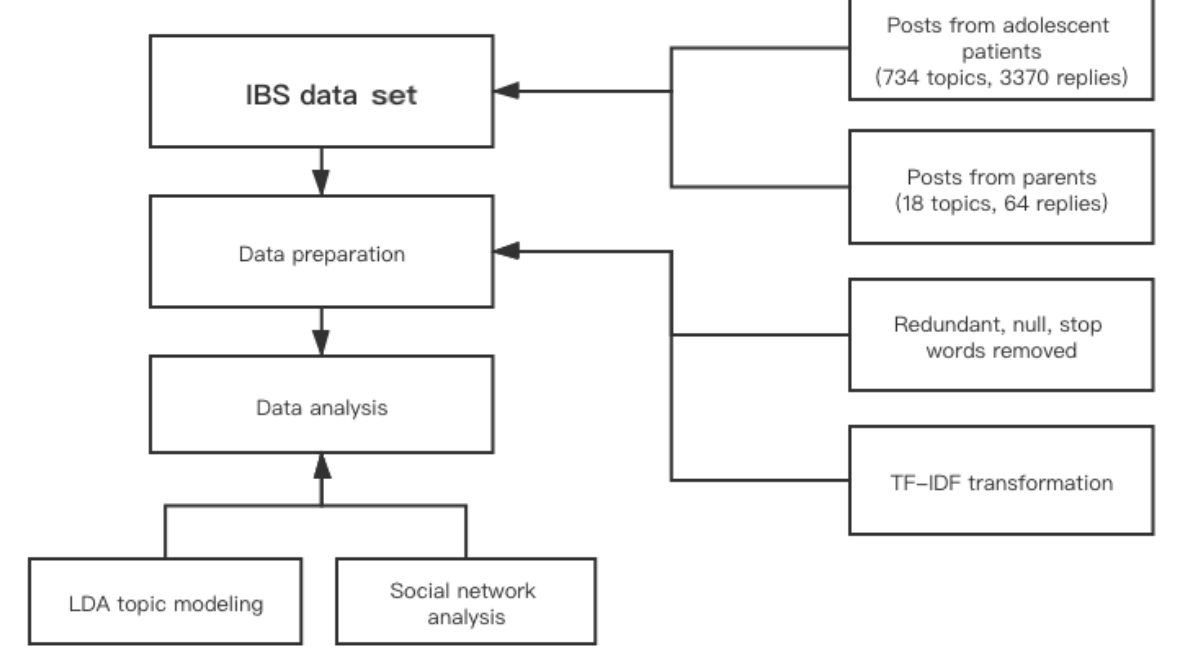
Figure 1. The process of data collection and analysis. IBS: irritable bowel syndrome; LDA: latent Dirichlet allocation; TF-IDF: term frequency-inverse document